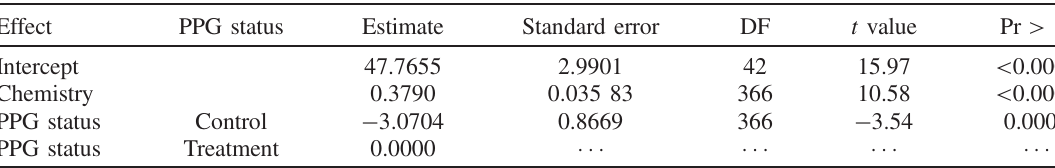
TABLE VIII. Model results for annual physics performance.